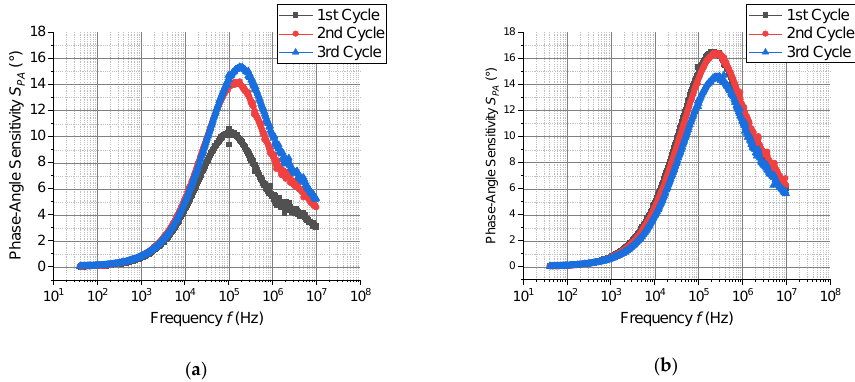
Figure 9. The dependence of phase-angle response vs. frequency for 100 ppm EtOH ( left ); 100 ppm EtOH + 100 ppm H 2 O ( right ). The reference atmosphere was synthetic air.